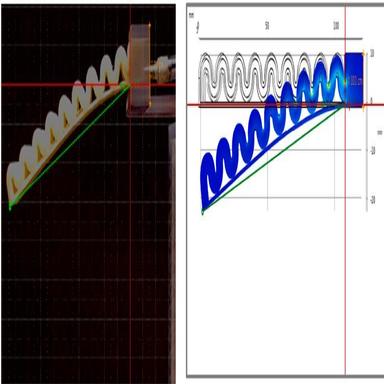
Displacement analysis (0 psi).